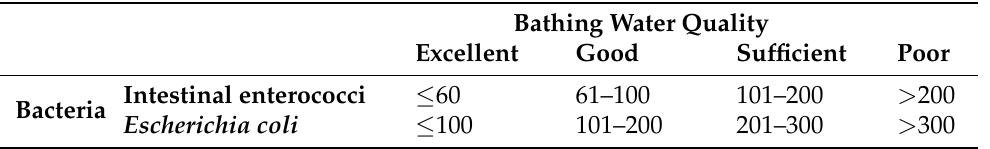
Table 1. Standards for bathing water quality after each